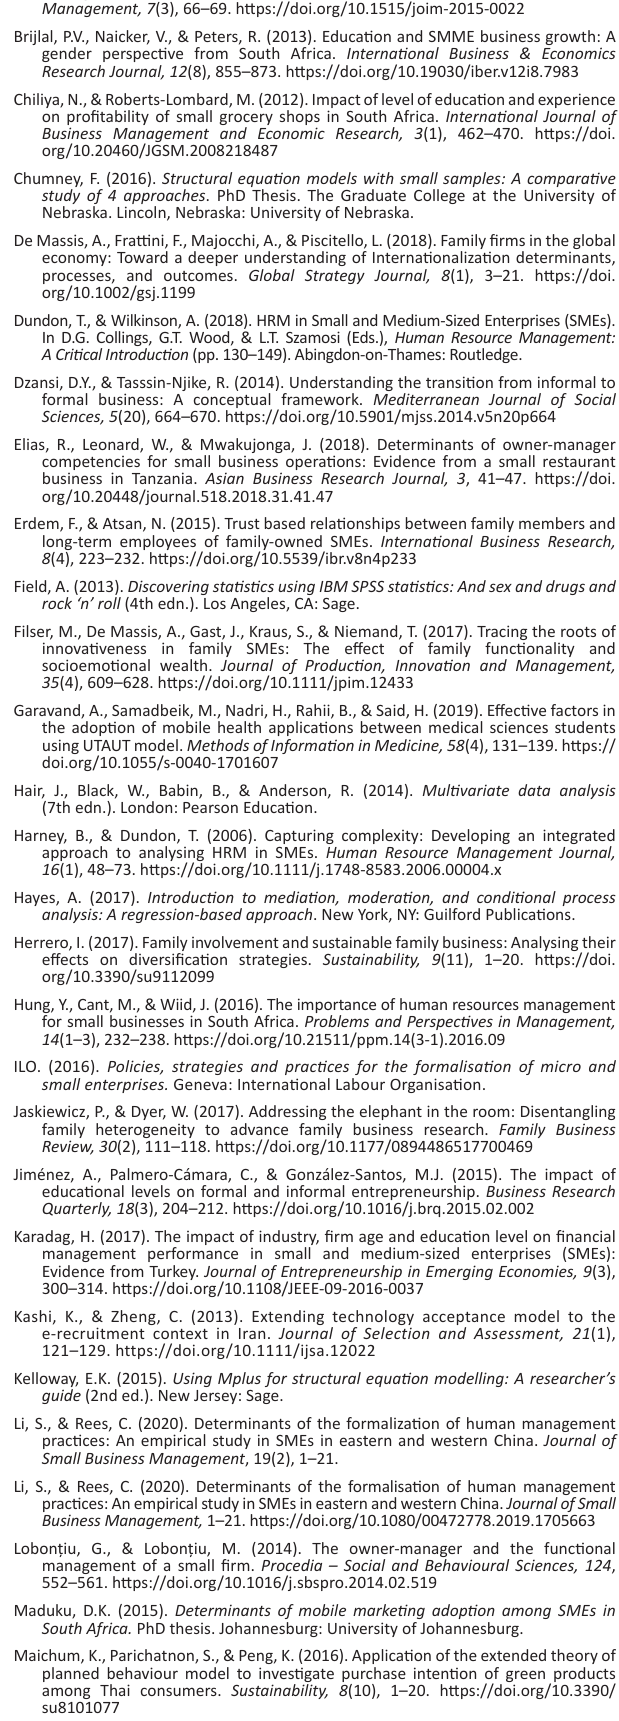
Owner-manager’s level of